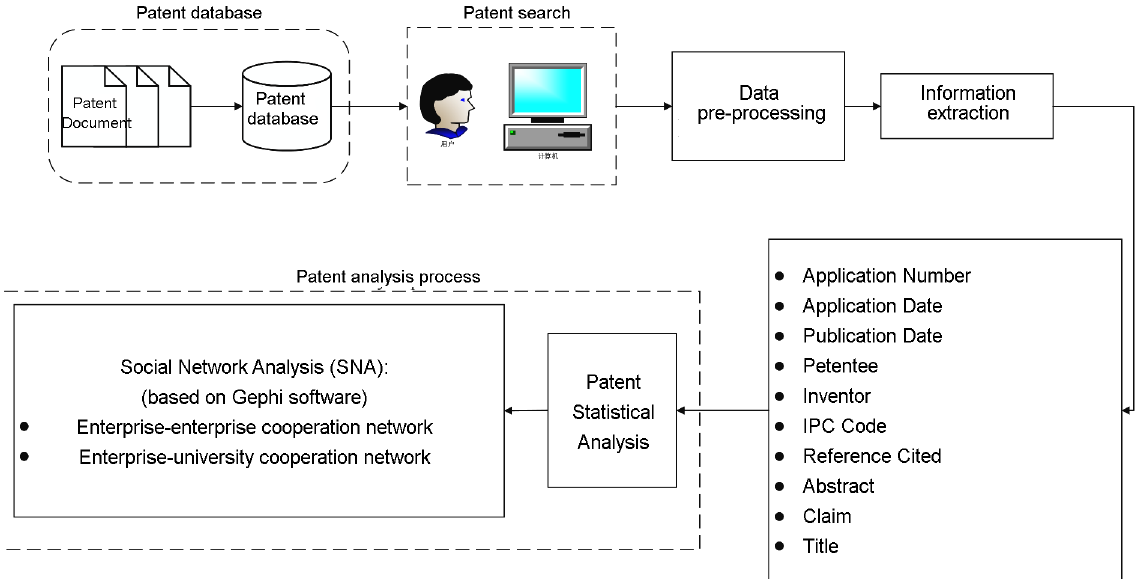
Figure 1. Research